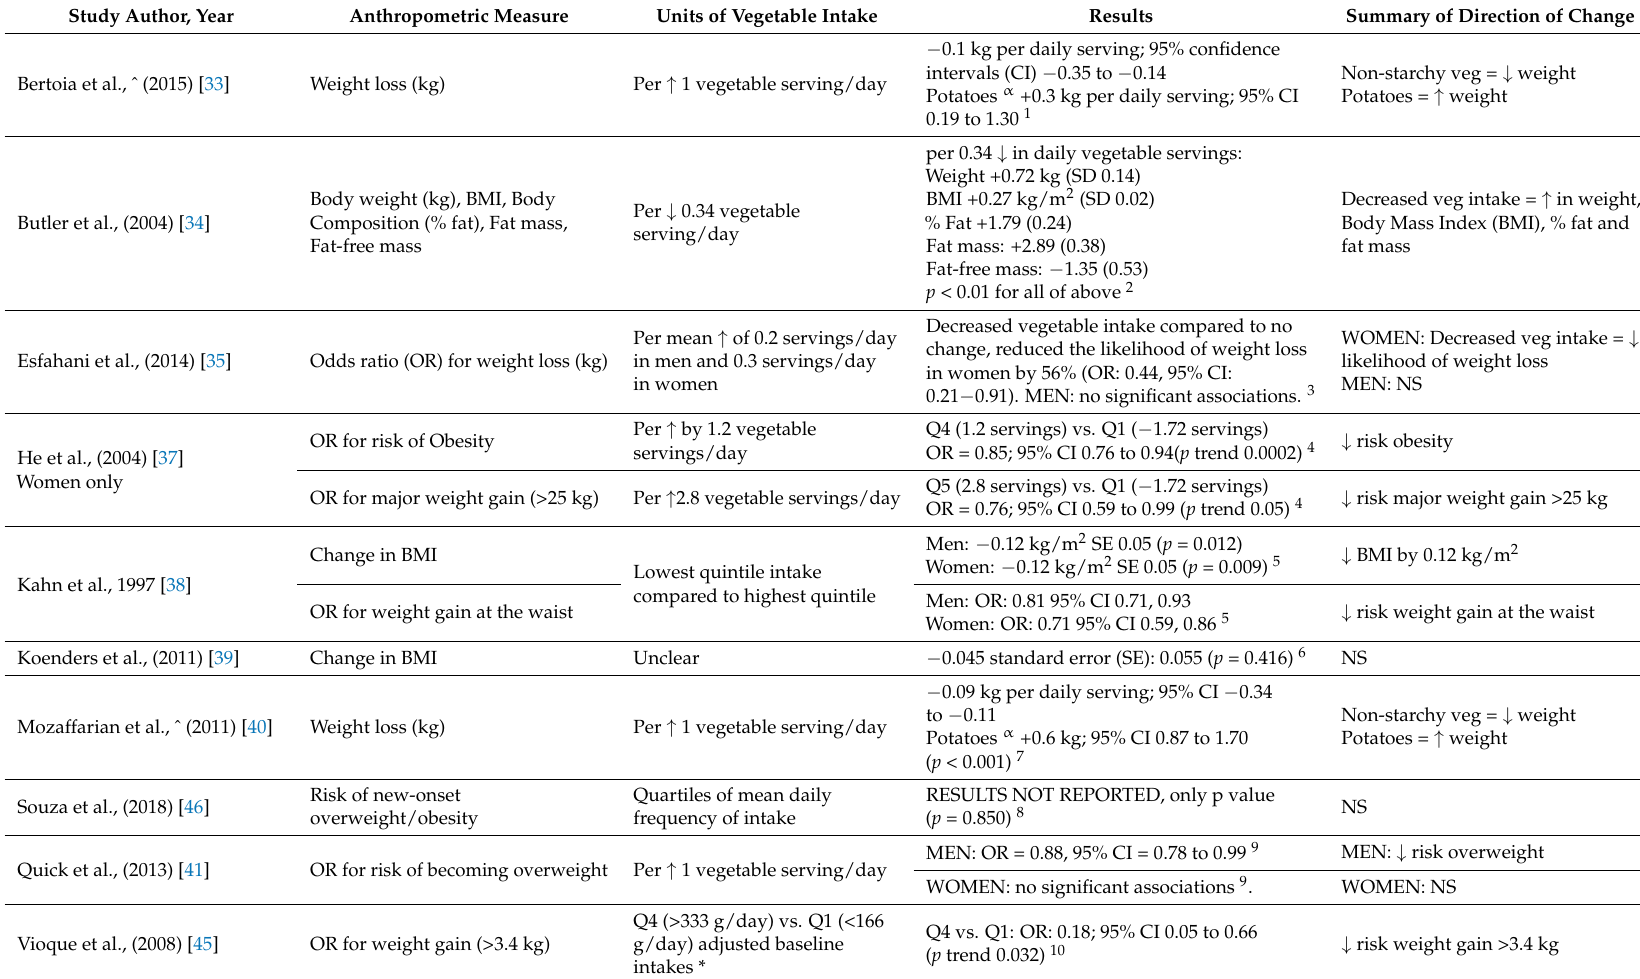
Table 5. Summary of results and direction of impact on anthropometric